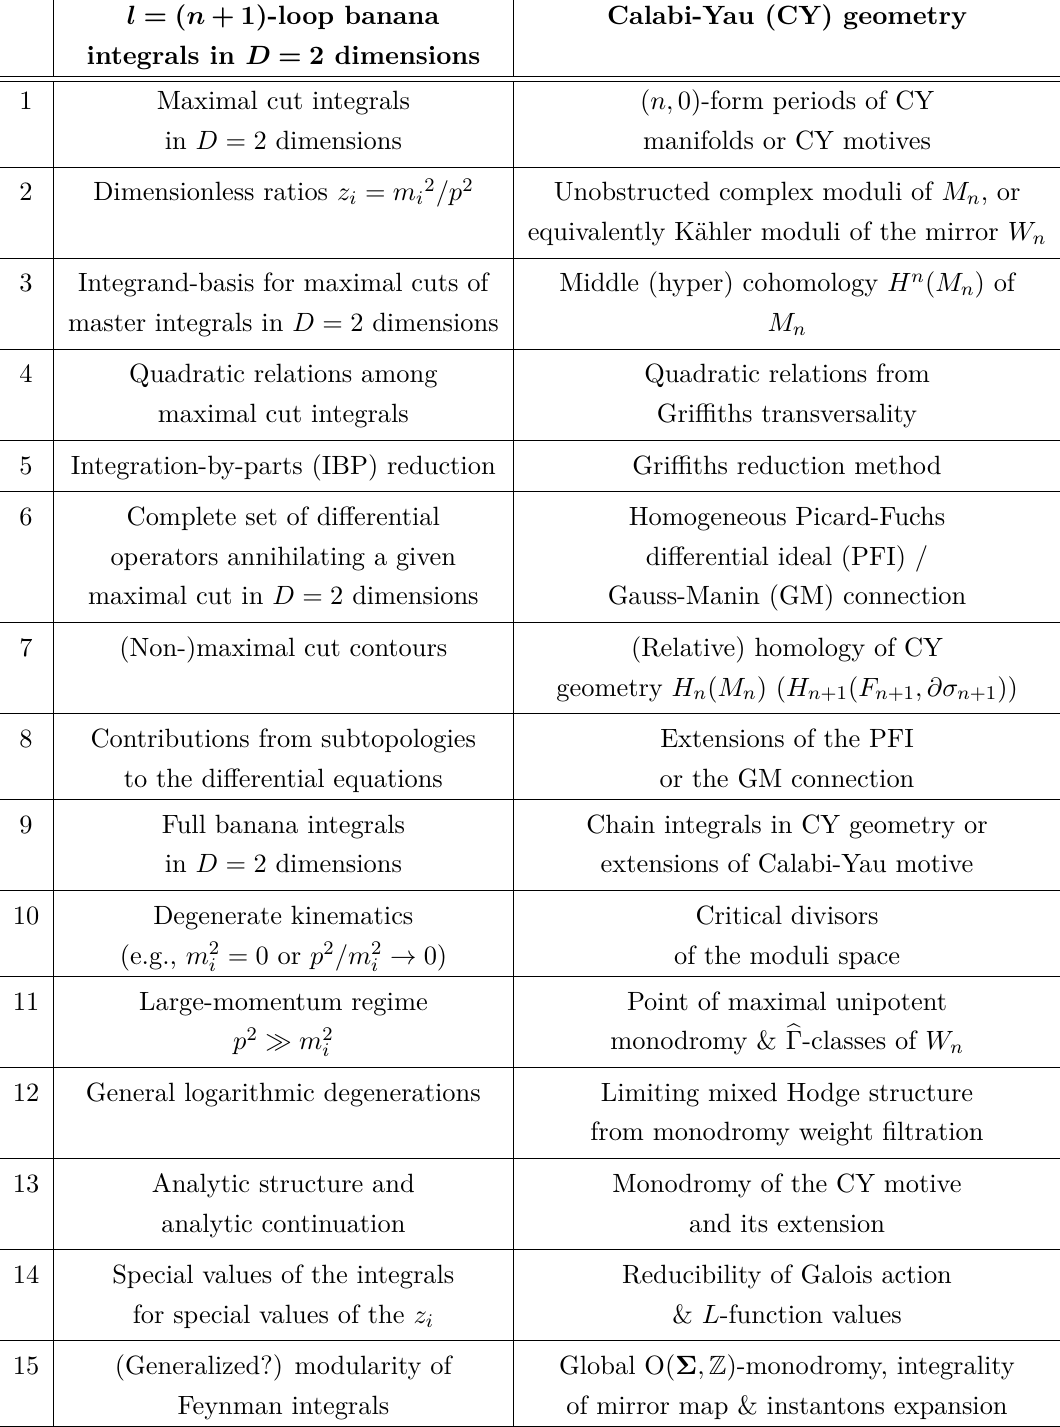
Table 1 . Relationship between concepts related to l -loop banana integrals and geometric structures related to Calabi-Yau